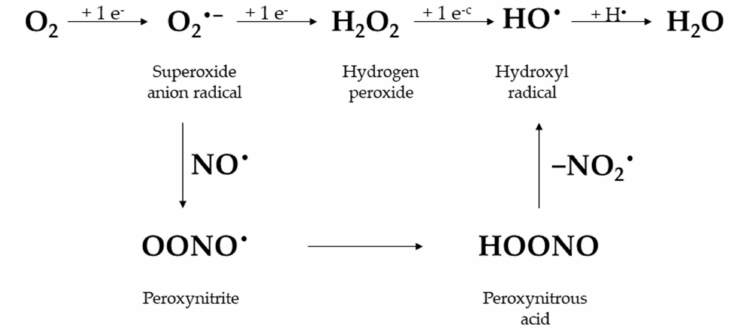
Figure 1. Some reactive oxygen and nitrogen compounds and relationships between them, redrawn from Greguška